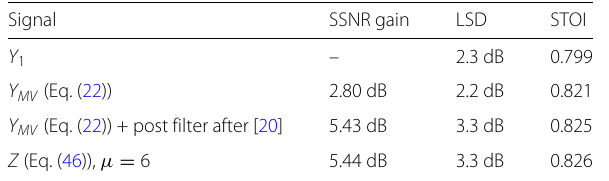
Table 2 Results for the post filter output for wind noise and driving noise